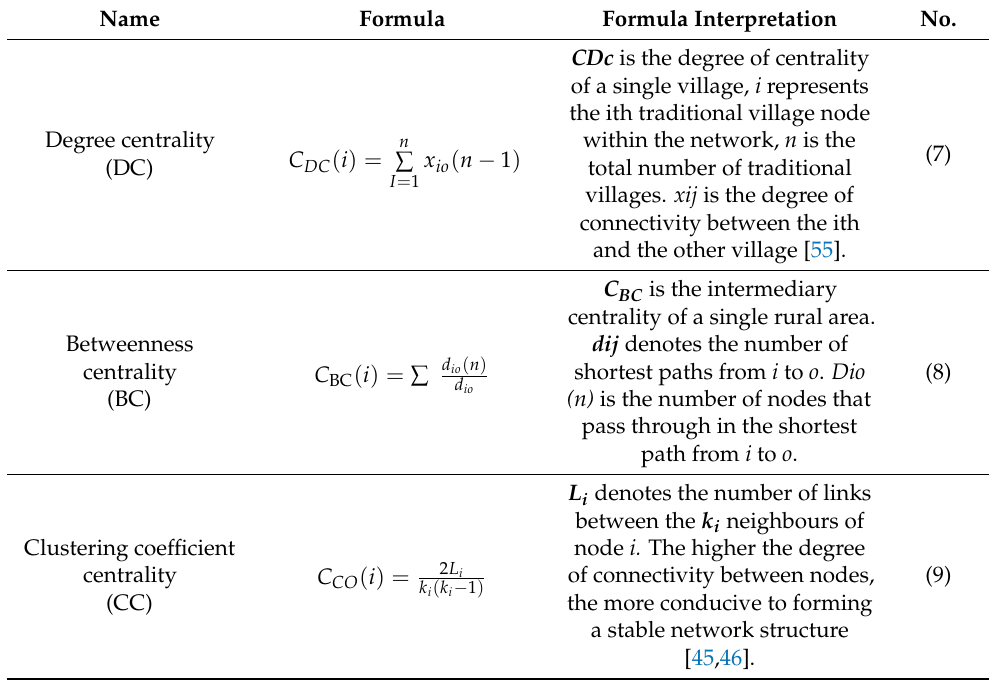
Table 3. Spatial networks indicator formula and